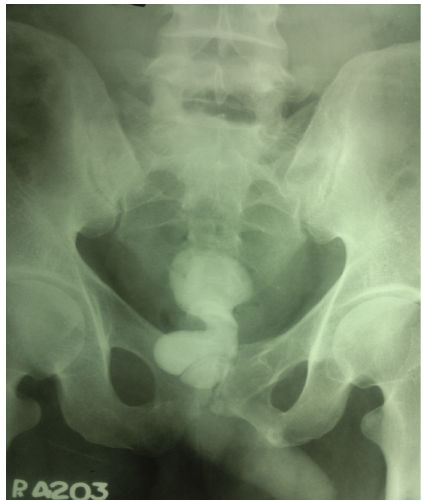
Figure 1: Erect X-ray KUB showing a giant calculus in the lower urinary tract.